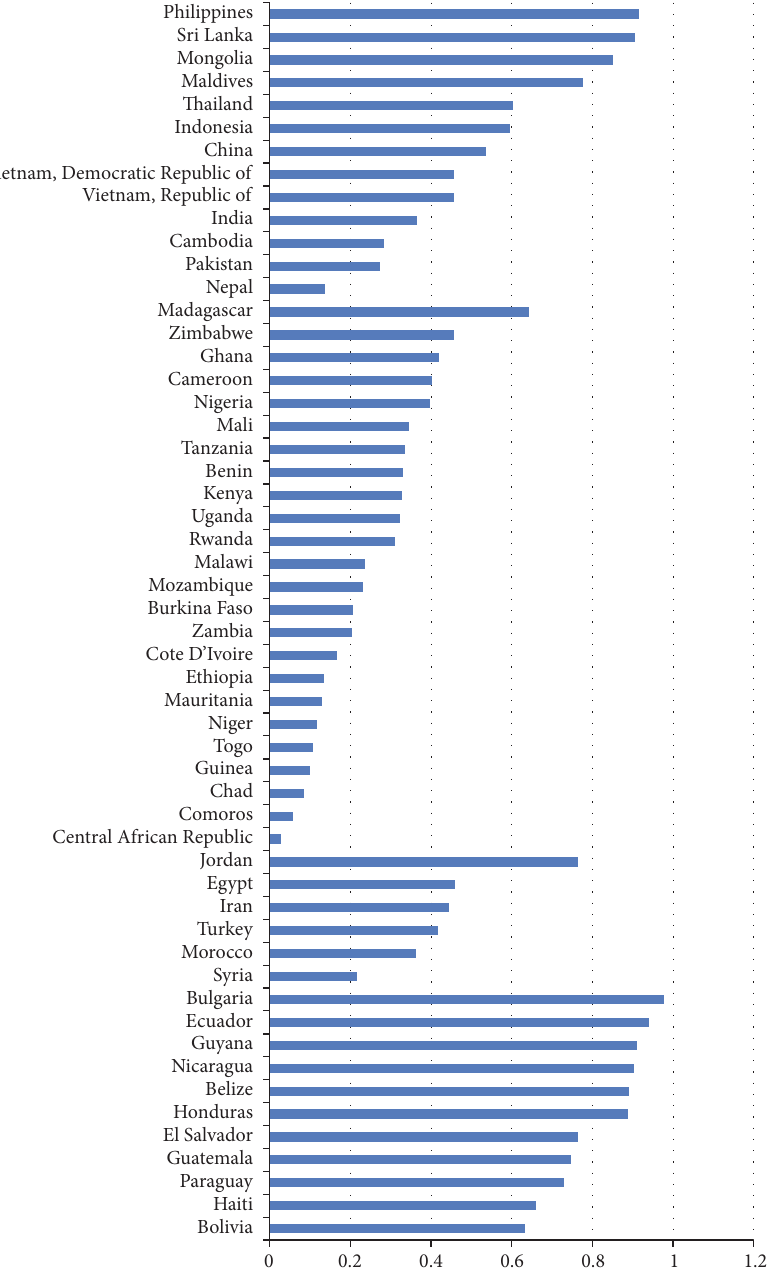
Figure 2: Developing countries: gender parity in secondary education by country,